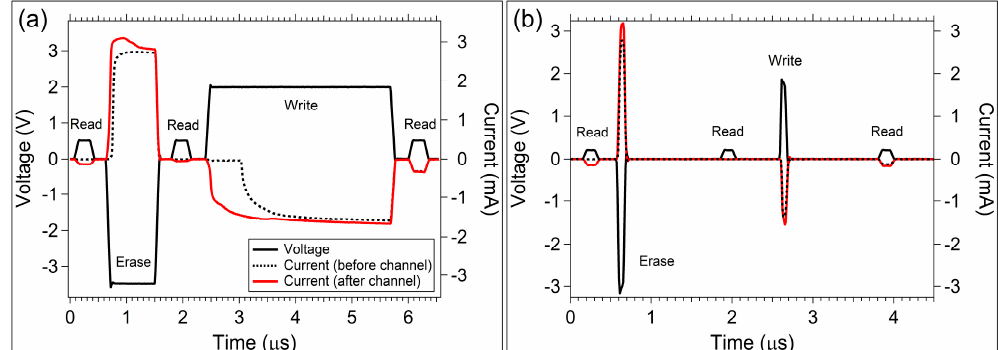
Figure 8. Cu and Ag device response to a programming pulse sequence. The solid black trace corresponds to the applied voltage pulse sequence. The dashed lines correspond to the current measured during the voltage pulse sequence for a pristine (before channel formation) device. The solid red line corresponds to the current measured during the next applied pulse sequence after channel formation. ( a ) Cu device; ( b ) Ag device. T = 300 K.